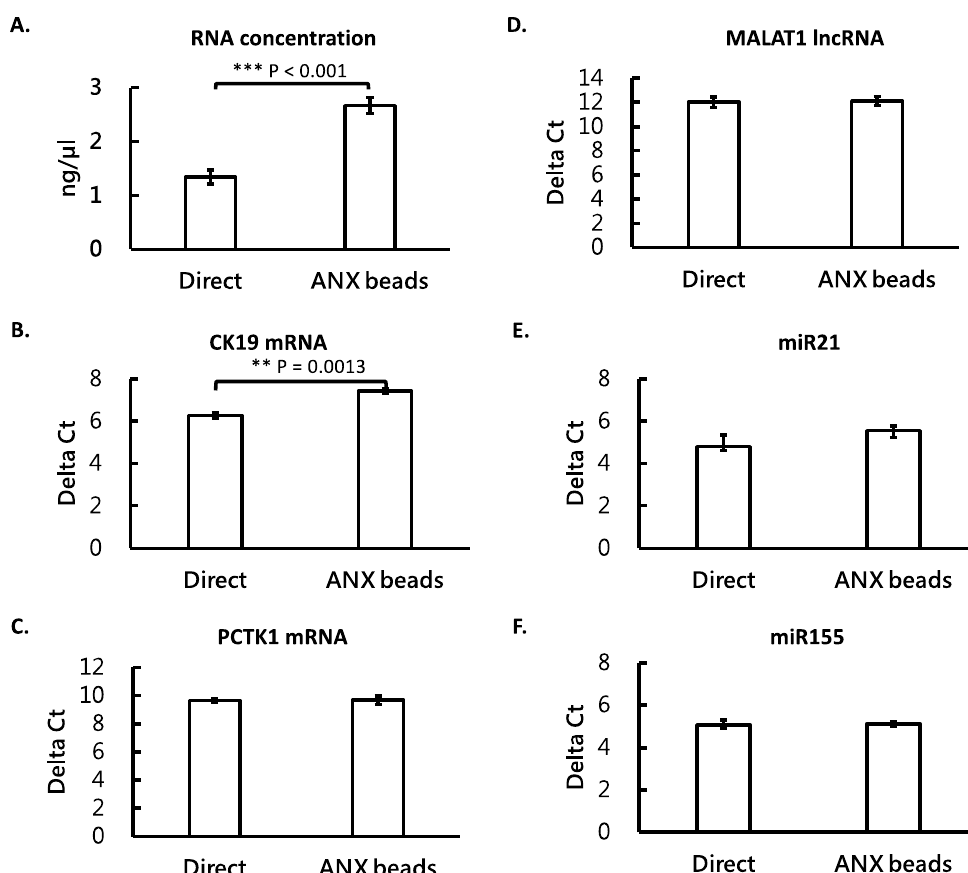
Figure 4. ANX beads could recover RNA from cultured medium. The media with living cells were either subjected to RNA extraction directly or first mixed with ANX beads to capture EVs and then subjected to RNA extraction. Total RNA concentration was determined by a fluorometer ( A ). The levels of different RNA species were measured by RT-qPCR. These RNA species included mRNAs-CK19 and PCTK1 ( B , C , respectively), lncRNA-MALAT1 ( D ), and miRNAs-miR21 and miR155 ( E , F , respectively). All the measurements were performed in triplicate and the bars are shown as mean ± standard error. Student’s t test was used to compare the groups. ** p < 0.01; *** p <